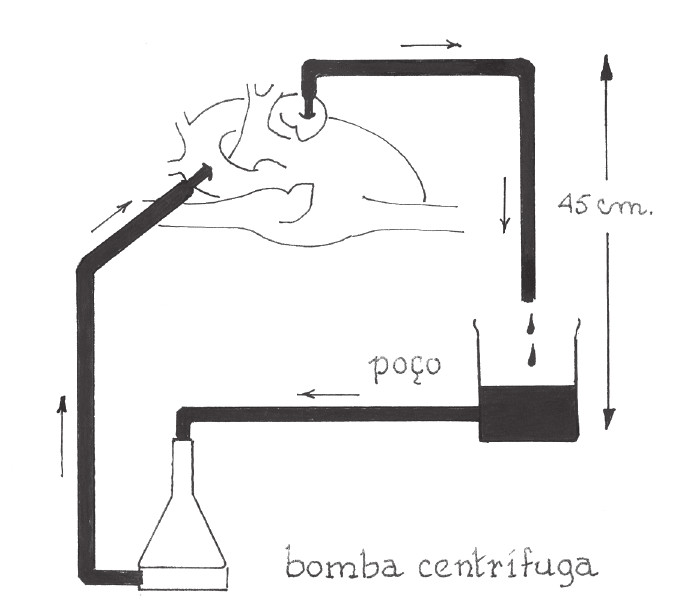
Fig. 1 – Esquema do circuito. O sangue é drenado do átrio esquerdo até um reservatório (poço) situado 45cm abaixo de onde é injetado na aorta mediante uma bomba